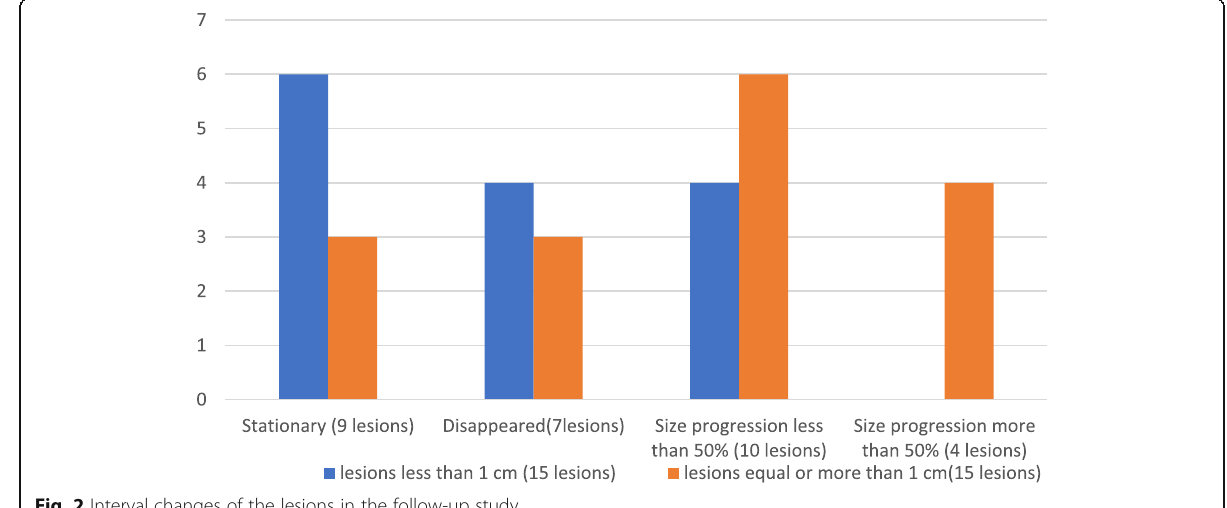
Fig. 2 Interval changes of the lesions in the follow-up study